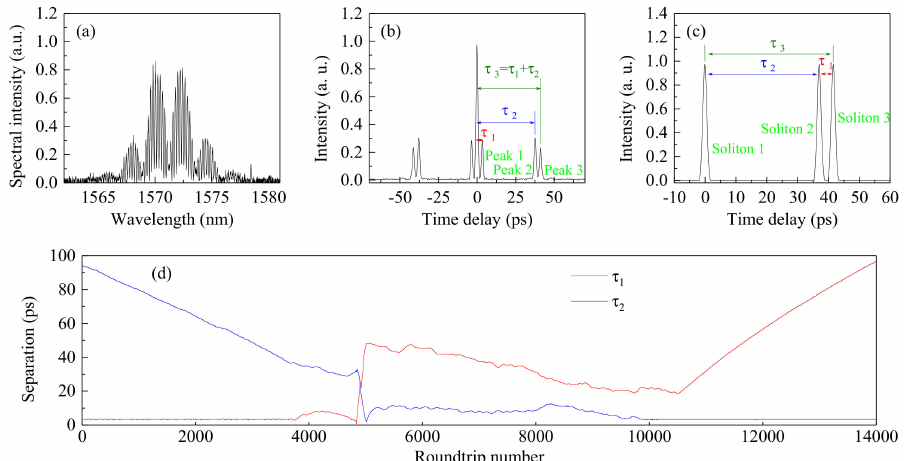
Figure 5. Retrieval of soliton separations. ( a ) The DFT spectrum at the roundtrip of 3600, ( b ) the corresponding field autocorrelation trace, ( c ) the actual temporal distribution of the solitons at the 3600th roundtrip, and ( d ) the retrieved separation evolution of the